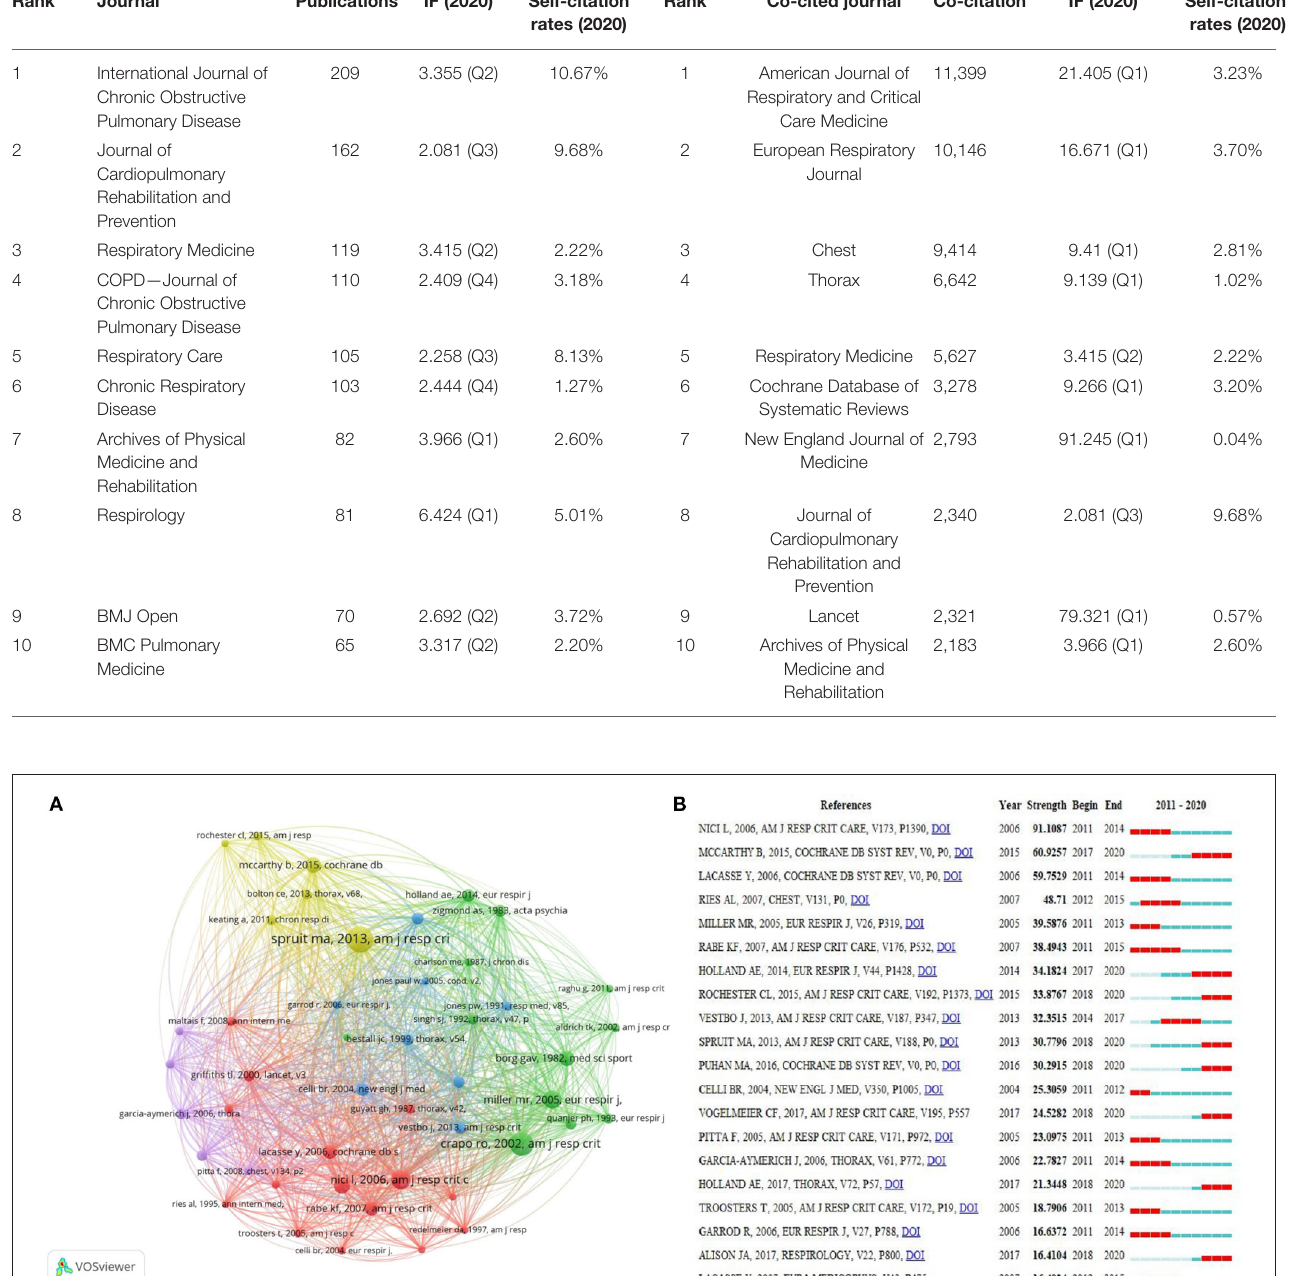
of related research were identified as follows: